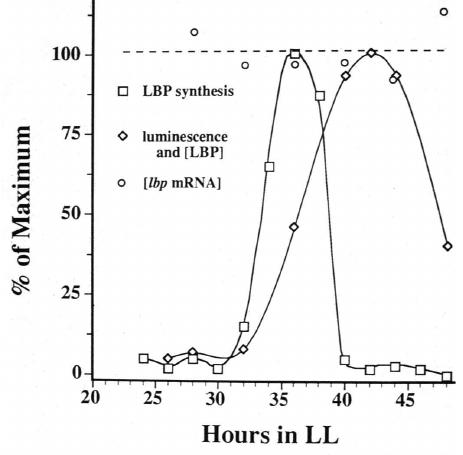
Figure 1. Measurements over time of the synthesis rate of luciferin binding protein (LBP) (squares, first peak), its abundance (diamonds) and the abundance of lbp mRNA (circles, dotted line), with cultures maintained in constant conditions.